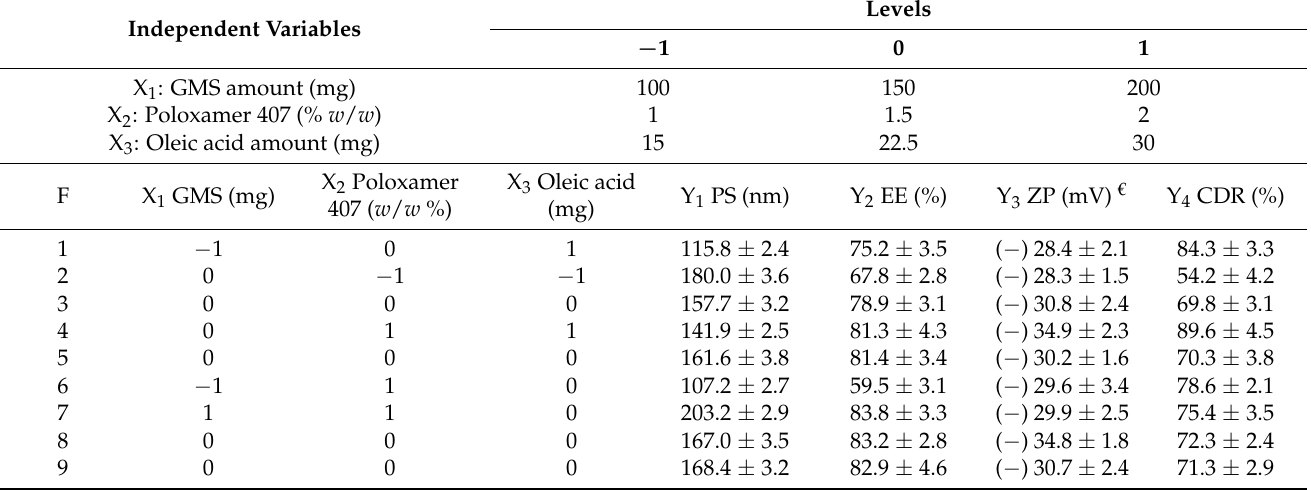
Independent and dependent variable values of NLC formulations according to Box–Behnken